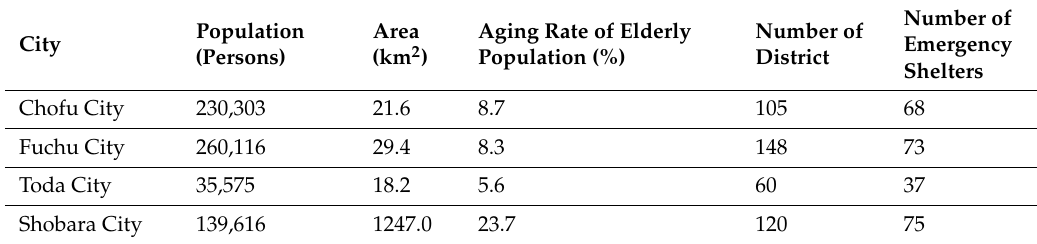
Table 2. Outlines of target